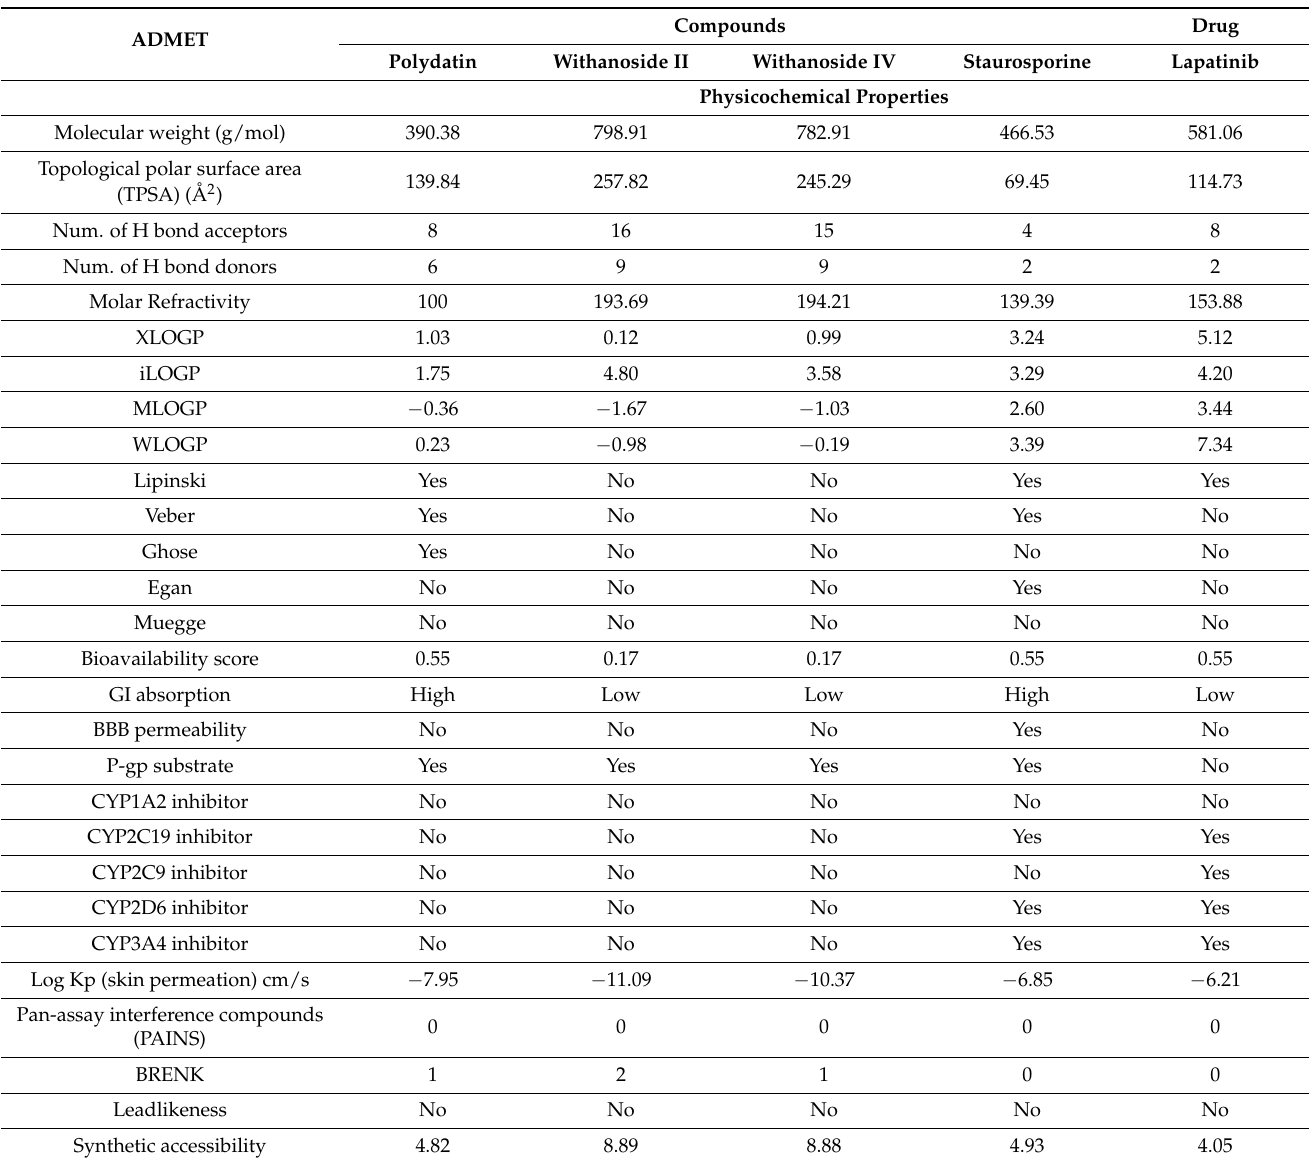
Table 3. ADMET properties of phytocompounds.